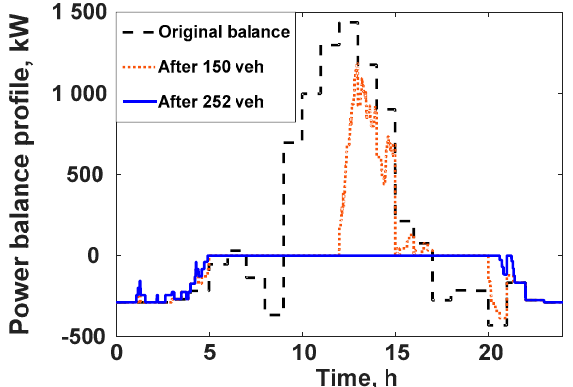
Figure 7. The original power balance profile and its change after different number of participating EVs. The curve 252 veh corresponds to the maximum total daily number of EVs awarded by a contract; the curve 150 veh is for illustration purposes to show the results of partial exploitation with less EVs than the prosumer needs to dispose its PV energy excess.